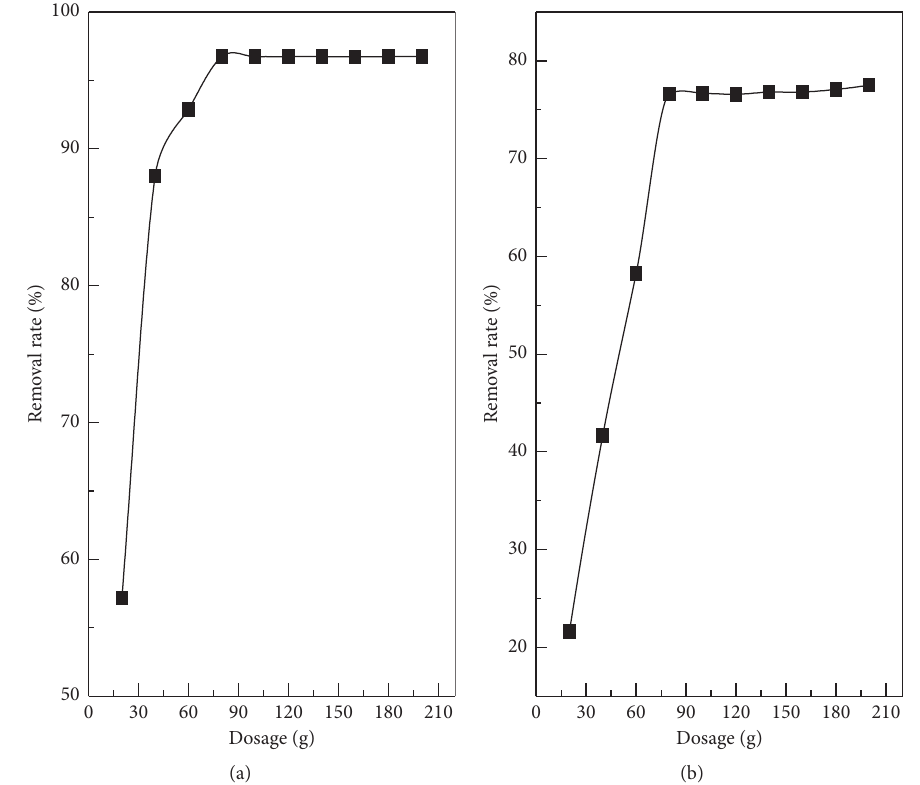
Figure 7: Effect of adsorbent dosage on the adsorption of wastewater (a) Cu (II) and (b) Cd (II) by SACL (experimental condition: Cu (II) concentration � 200mg · L − 1 ; Cd (II) concentration � 200mg · L − 1 ; contact time � 180min; pH � 4; temperature � 25 ° C; and agitation speed � 150rpm) (error bars represent the standard deviation of three